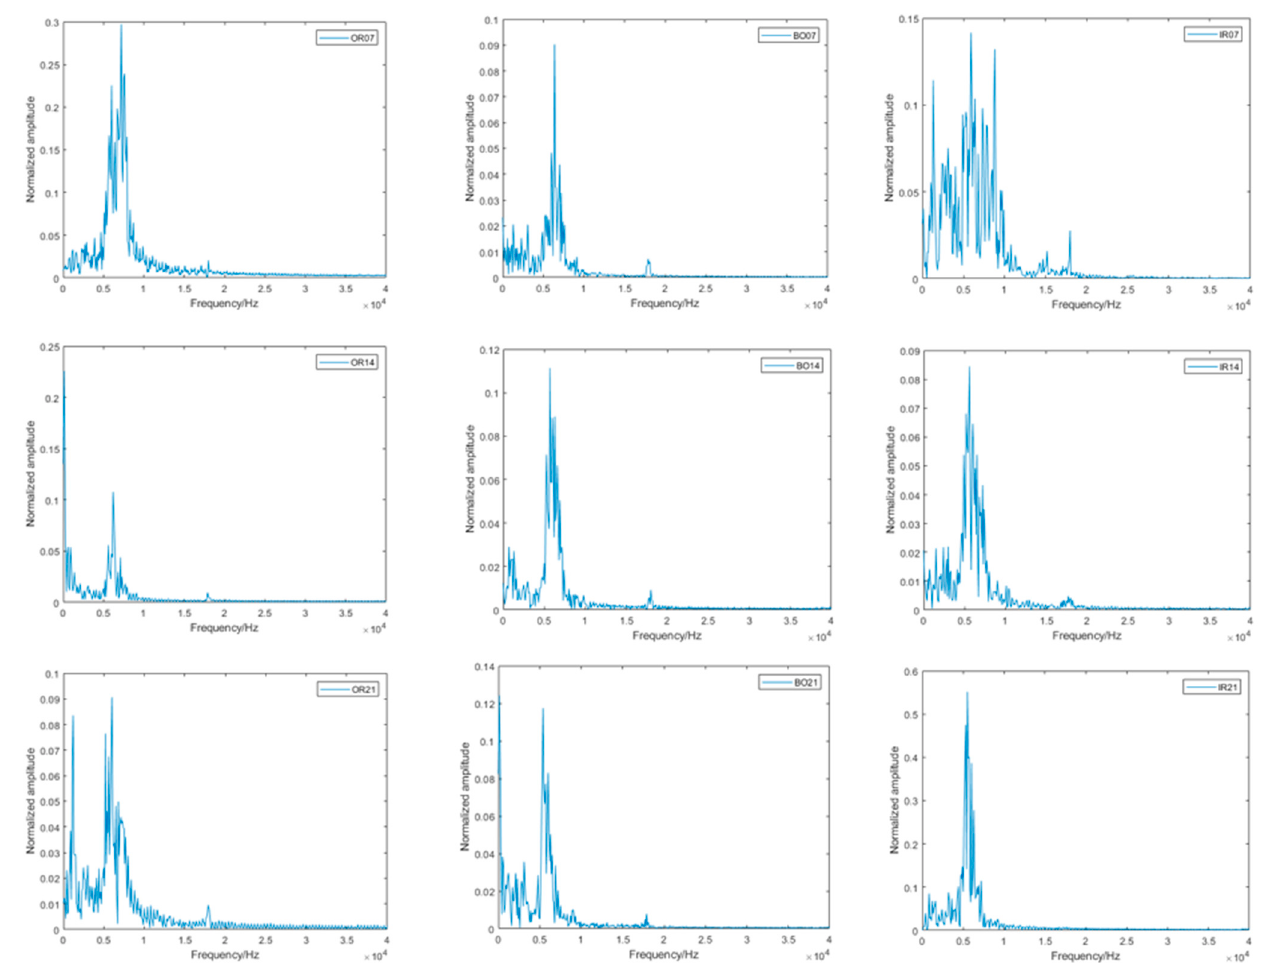
Figure 10. FFT analysis of rolling bearing faults data.